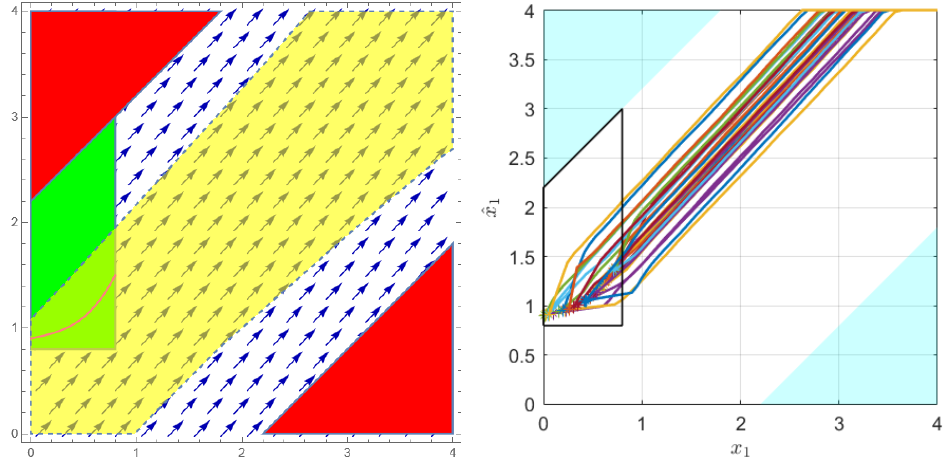
Figure 4. ( Left ) Phase portrait of Example 2 with x 2 = ˆ x 2 = 0.05 and x 3 = ˆ x 3 = 0.05. The pink line and the green, red, and yellow regions are the initial sets (cid:101) Θ 0 and Θ 0 , the unsafe set Θ u , and the sub-level set of B ( x , ˆ x ) , respectively. ( Right ) State runs of Π × Π on the projection of the x 1 plane starting from (cid:101) Θ 0 . The blue region represents the unsafe set Θ u